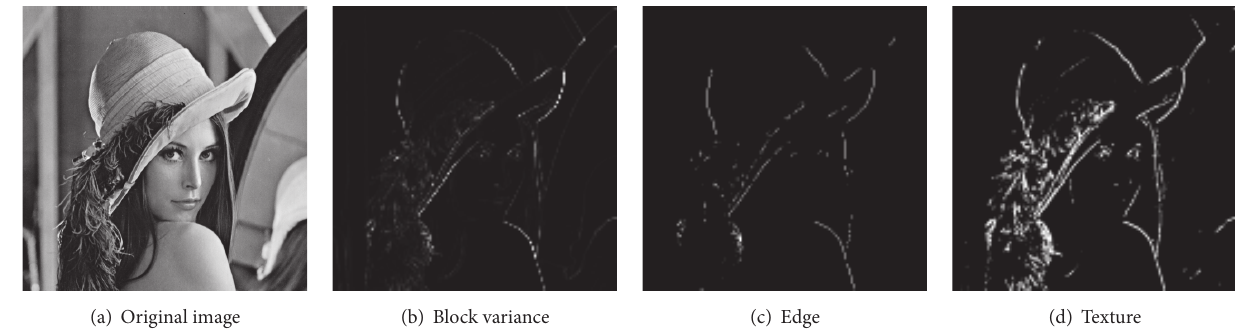
Figure 3: Comparison of feature maps based on block variance, edge, and texture for 512 × 512 Lenna